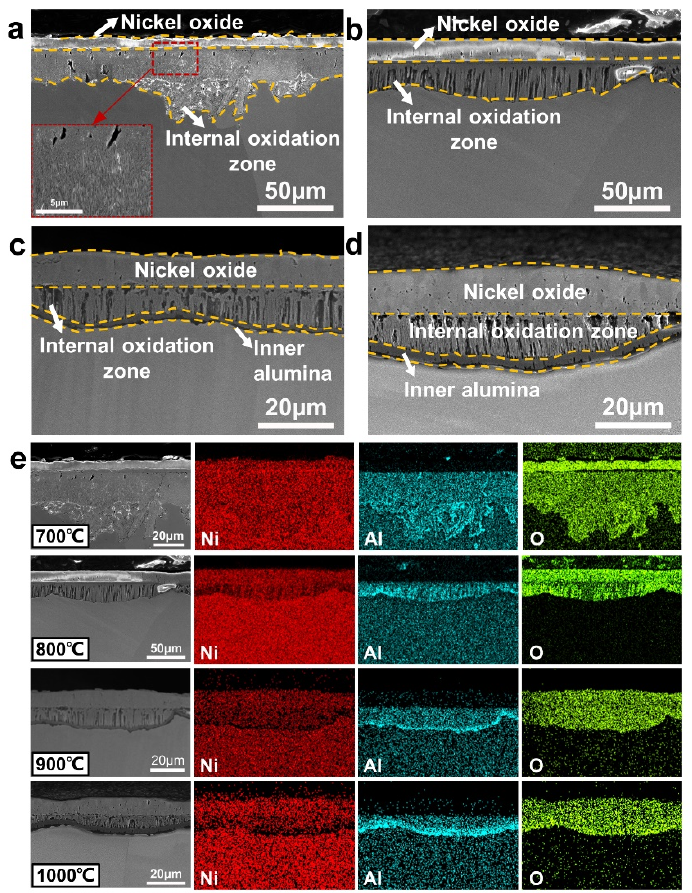
Figure 5. Cross-sectional microstructures (SE images) of oxide scales formed on Ni-15Al alloy oxidized at ( a ) 700 °C, ( b ) 800 °C, ( c ) 900 °C, and ( d ) 1000 °C for 576 h. Note that the formation of the alumina layer can effectively inhibit internal oxidation. ( e ) EDS maps of oxide scales formed on Ni-15Al alloy at temperatures ranging from 700 °C to 1000 °C.